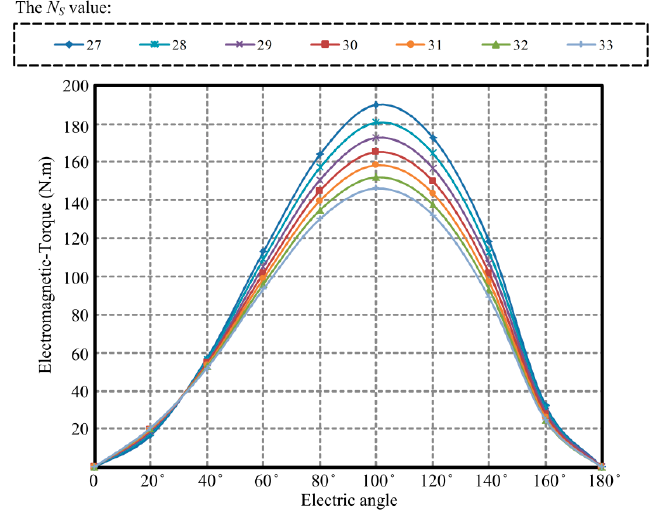
Figure 4. Torque angle characteristic curve with different N S values.